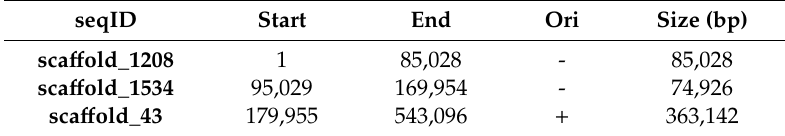
Table 1. Contigs containing alternative haplotypes of the sex-determination region